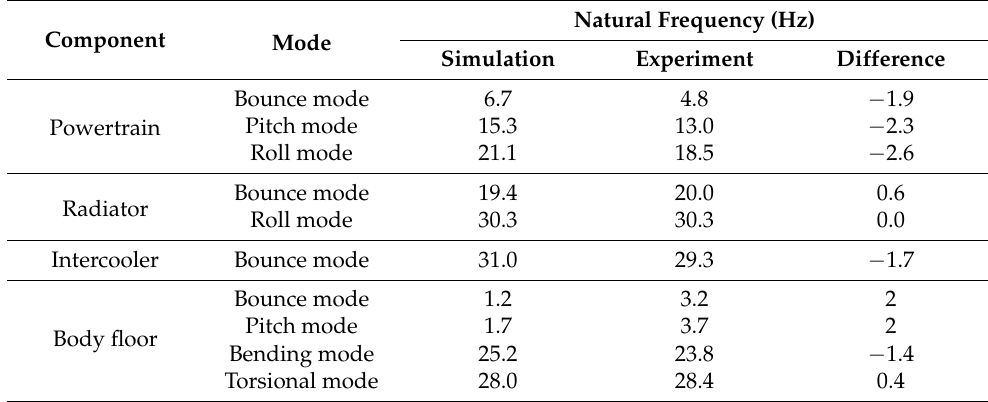
Table 3. Comparison of the natural frequencies obtained by simulation and